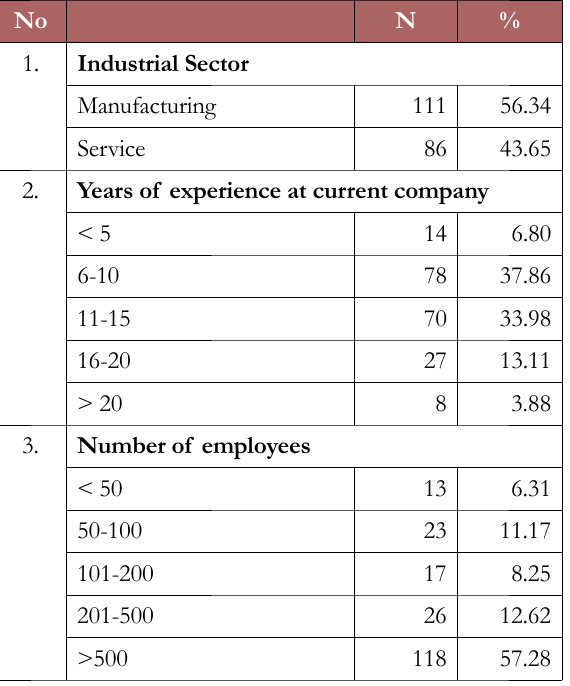
Table 1. Demographic profile of the middle managers as